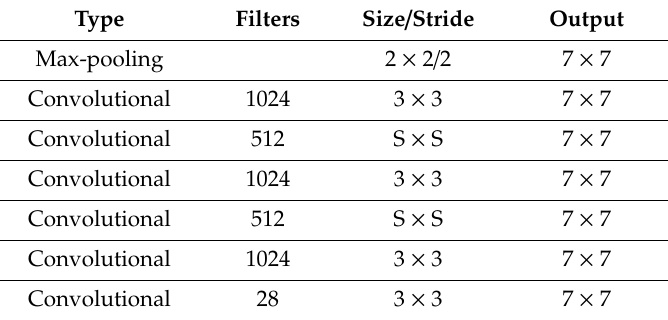
Table 3. Configuration of TSBBR for large